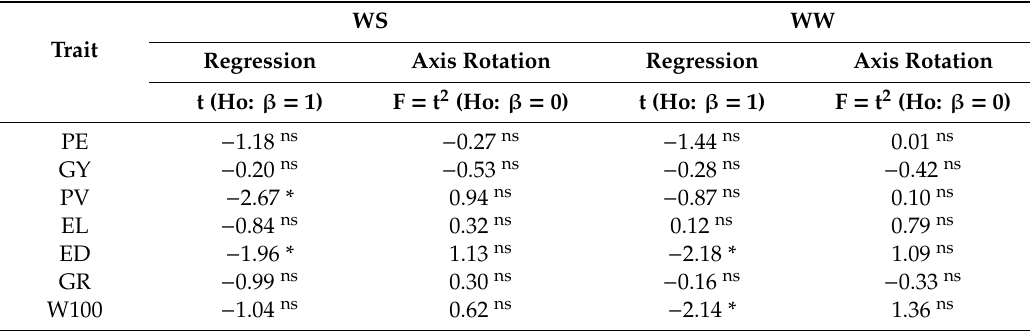
Table 3. Su ffi ciency tests of the additive dominance model based on linear regression analysis of ˆ W as a function of ˆ V of the traits evaluated in popcorn genotypes under water-stress (WS) and well-watered (WW) conditions.